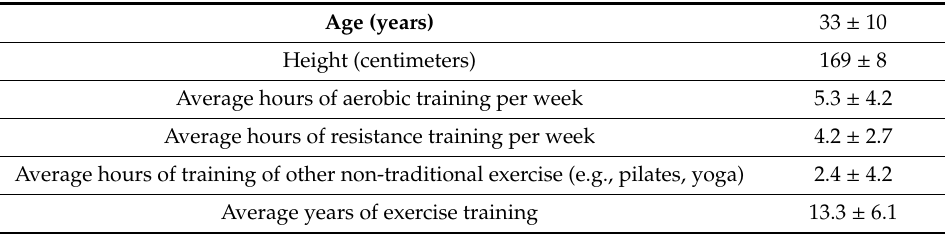
Table 1. Physical Characteristics and Training